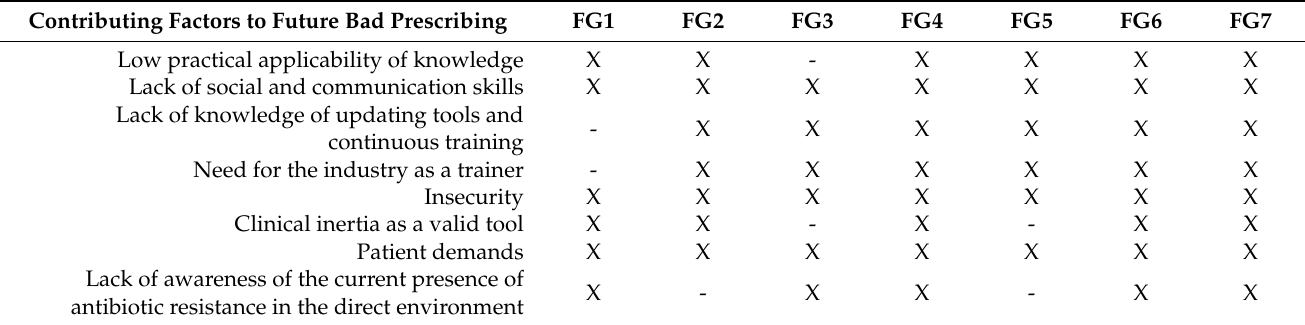
Table 3. Saturation of information on identified factors contributing to inadequate future